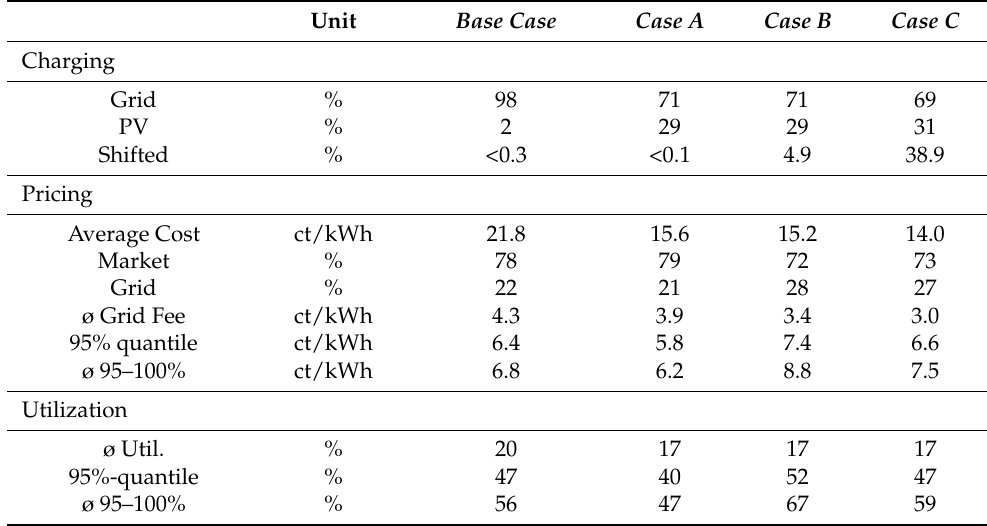
Table 3. Result overview for the scenarios with a used PV potential of 80%.